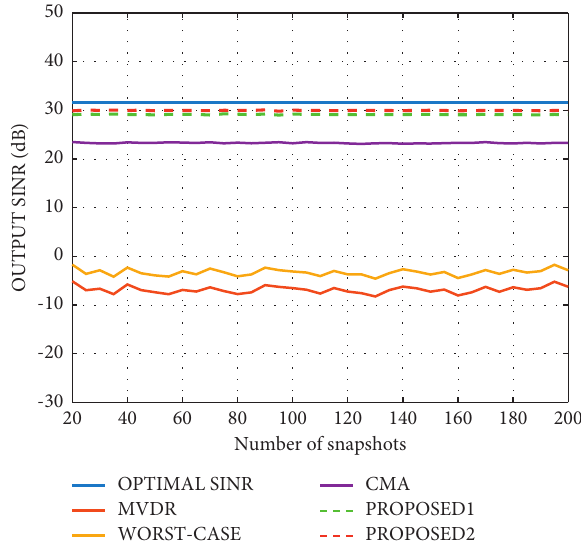
Figure 10: Random look direction mismatch: output SINR versus the number of snapshots.